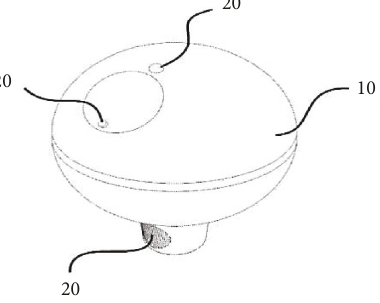
Figure 2: Patented on smart device for swimming